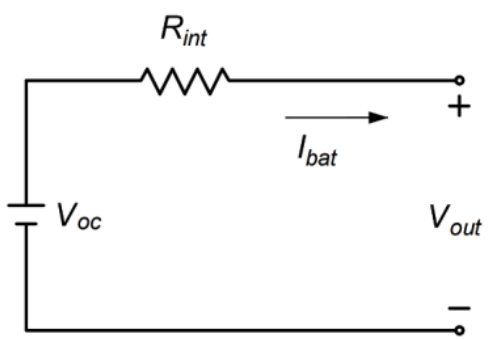
Figure 2. Equivalent circuit of the battery.